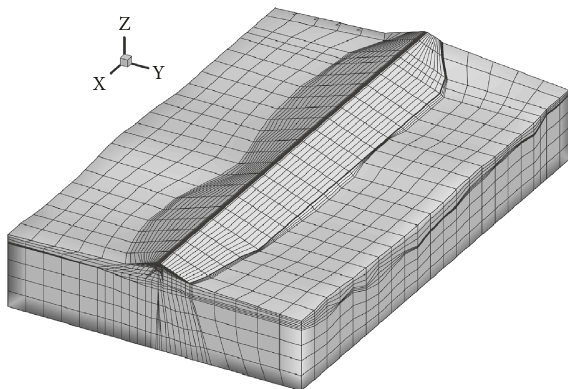
Figure 5: Three-dimensional finite element model of the No. 4 dam of Gongming